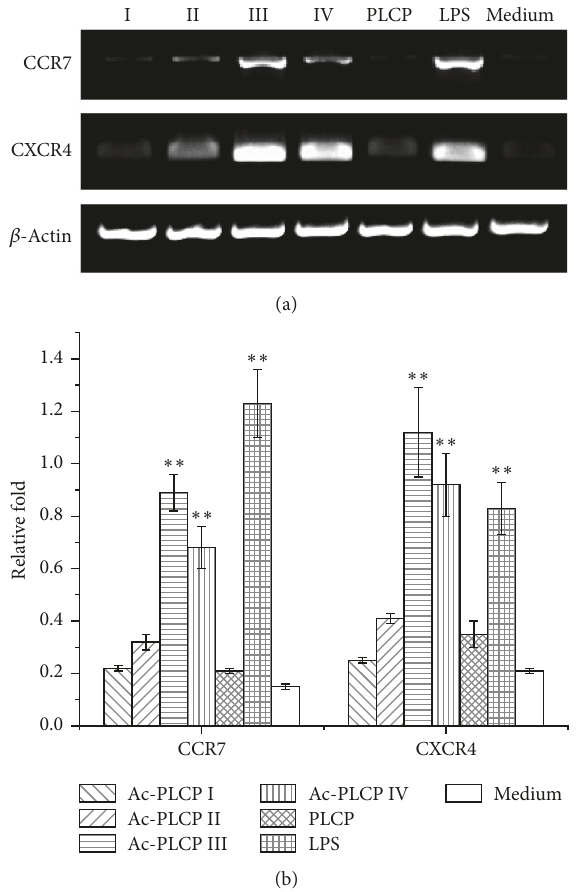
Figure 5: mRNA synthesis levels of CCR7 and CXCR4 were deter- mined through reverse transcriptase PCR. The PCR product was analyzed by 1.5% agarose gel electrophoresis. The mRNA expression levels of both CCR7 and CXCR4 were significantly increased in Ac-PLCP III and IV groups. Besides, the expression of 𝛽 -actin in each group was determined as internal control, and there was no significant difference among all the groups. ∗∗ 𝑃 < 0.01 compared with PLCP group.